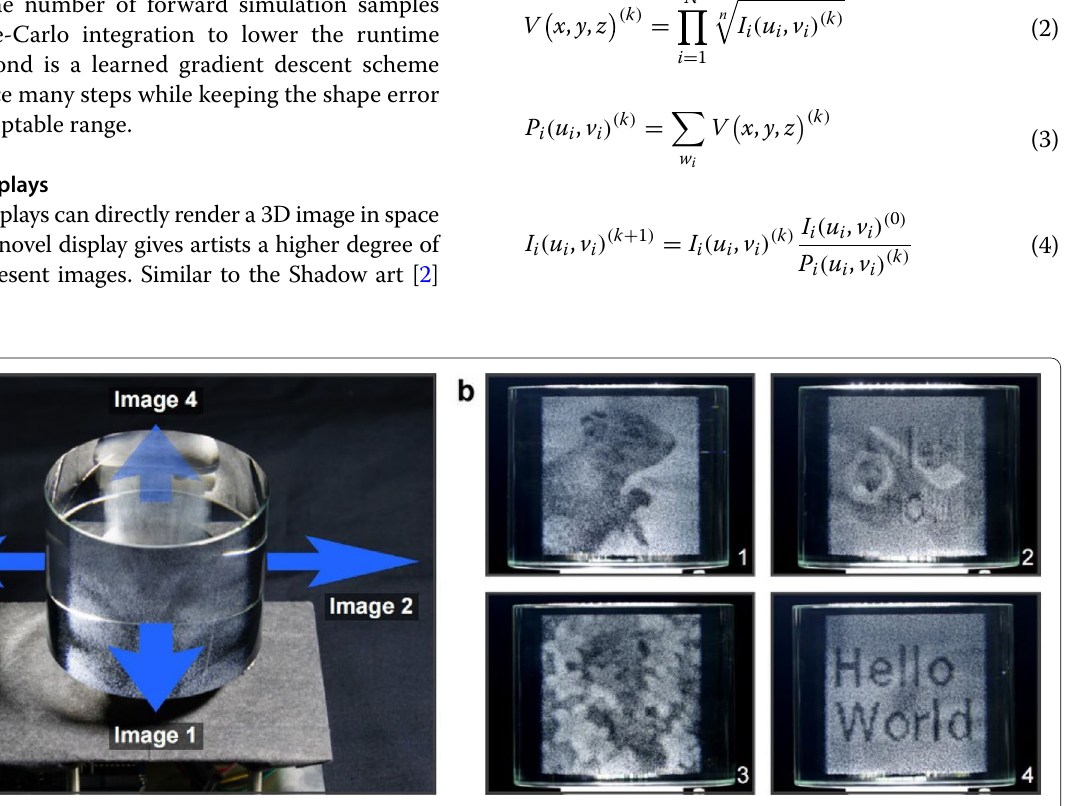
Fig. 22 a Volumetric displays can project different images in different directions [59]; b Four images displayed by a cylindrical 3D